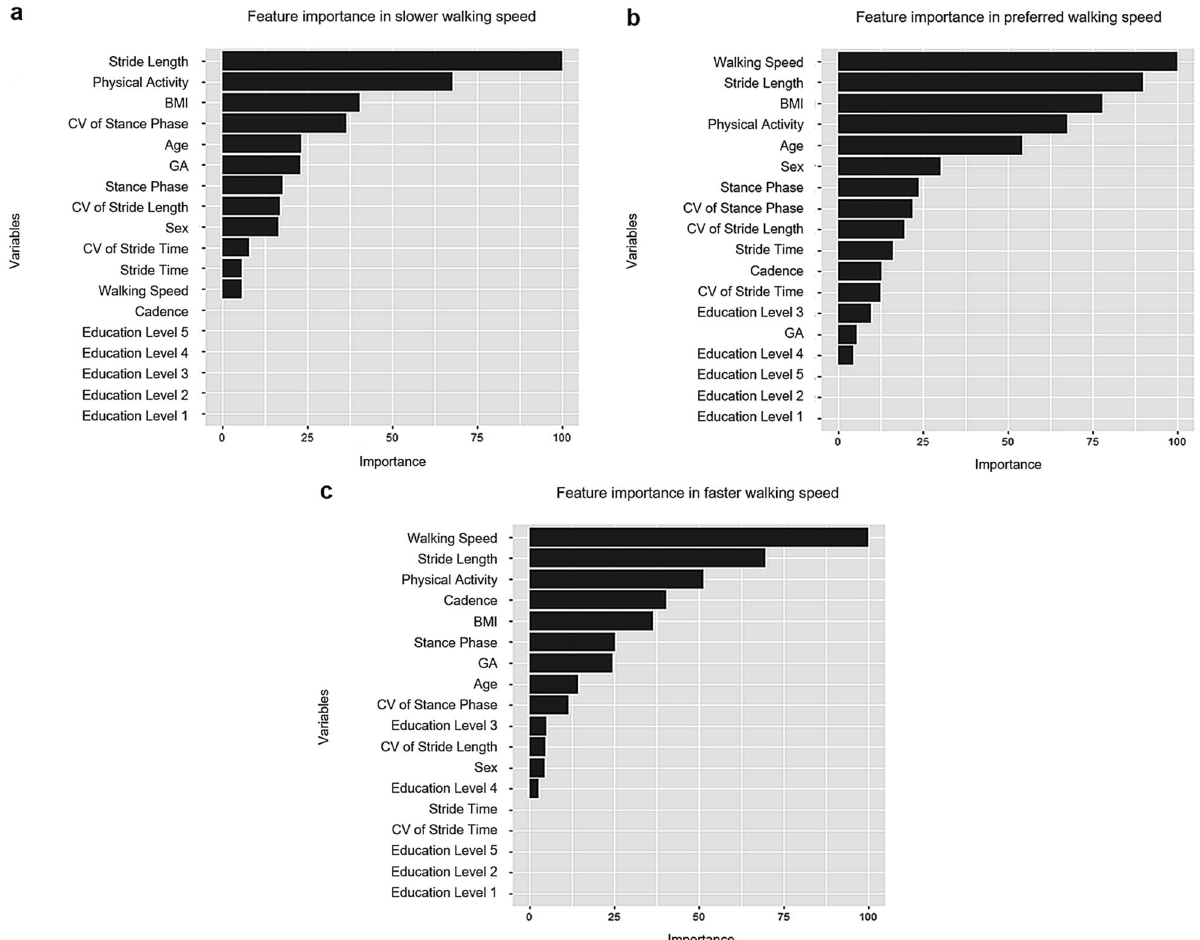
Figure 3. Important features for each walking speeds using the XGBoost models. ( a ) Results of feature selection for the slower-walking, ( b ) preferred-walking, and ( c ) faster-walking speed ing, and faster-walking speed models, respectively. The specificities were approximately 84%, 81%, and 77% in the slower walking, preferred walking, and faster-walking speed models, respectively (Table 3). In the study, the feature importance was calculated through XGBoost to determine the features having an optimal effect when determining the risk of falls. The feature importance is the score result indicating how each variable contributes to the model accuracy when creating the XGBoost model. Figure 3 shows the result of deriv- ing the importance of the main features among all the explanatory variables. As shown in Fig. 3, the most impor- tant features are stride length (slower speed) and walking speed (preferred and faster speed) for determining in which the fall into a high- or low-risk groups. Additional important features in the slower-walking speed model among the top 10 were CV of stance phase, GA, stance phase, CV of stride length, CV of stride time, and non- spatiotemporal parameters such as PA level, BMI, age, and gender. Additional features in the preferred-walking speed model included stride length, stance phase, CV of stance phase and stride length, and stride time with